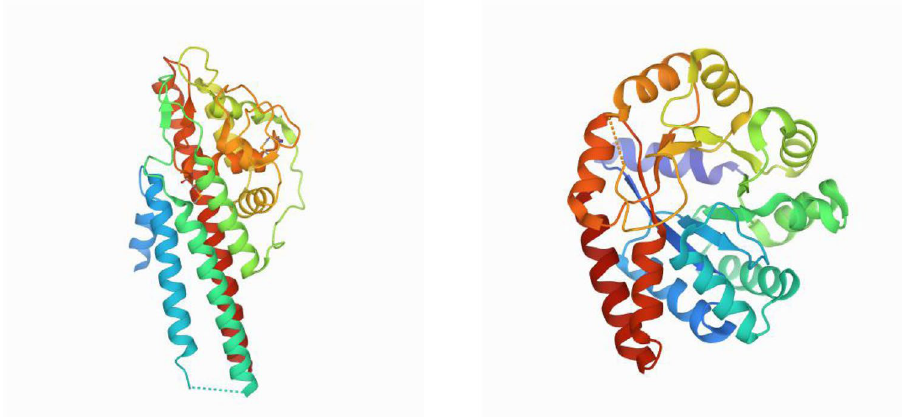
Figure 2. Protein 1l8w (left) and protein 1qop (right). They both have similar Writhe and ACN but different v 2 values. Namely, Protein 1l8w has Wr = 28.27, ACN = 143.61 and v 2 = 0.022 . Protein 1qop has Wr = 23.00797, ACN = 131.5524 and v 2 = 0.229